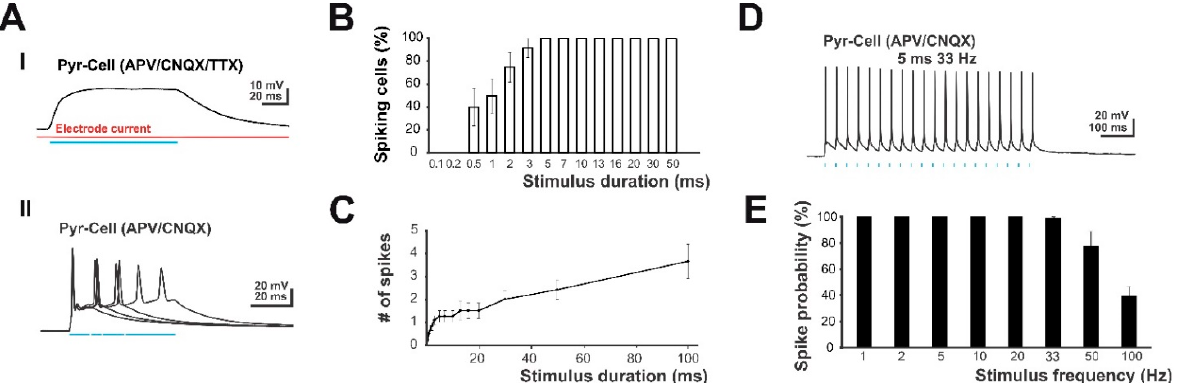
Figure 3. Patch clamp analysis of light-induced membrane responses in genetically modified cortical neurons expressing ChR2 and H2B-mCherry. ( A ) Patch clamp analysis of light-induced membrane responses in ChR2 transfected neurons. Panel I. Voltage-trace of a ChR2 transfected neuron upon 100 ms long illumination with blue LED light after inhibition of action-potential generation and synaptic transmission. The red trace illustrates the current of an unattached patch clamp pipette at a holding potential of 0 mV. Note that illumination induced a stable depolarization and had virtually no effect on the electrode alone. Panel II: Superimposed voltage traces of a ChR2 transfected neuron upon illumination for 10, 15, 20, and 40 ms after inhibition of synaptic transmission only. Note that illumination reliable induces action potentials and that at durations ≥ 15 ms, more than one AP was induced. ( B ) Response probability of the neuron upon stimulation using different stimulus durations. Note that reliable suprathreshold stimulations were induced at durations ≥ 5 ms. ( C ) Statistical analysis of the dependency between duration of illumination and the number of spikes. Note that between 5 and 15 ms duration, mainly a single AP was induced. ( D ) Voltage trace of a ChR2-positive neuron that was repetitively stimulated by light pulses. Note that this neuron reliably follows this individual burst stimulation. ( E ) Statistical analysis of spike probability at different stimulus frequencies. Note that AP generation reliably follows the repeated stimulation at frequencies of up to 33 Hz.